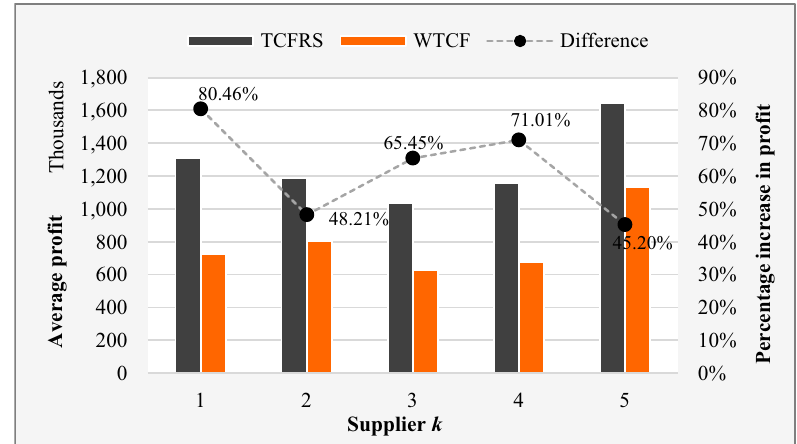
Fig. 4 The effects of the TCFRS contract on the supplier’s profit for test problems in size 1